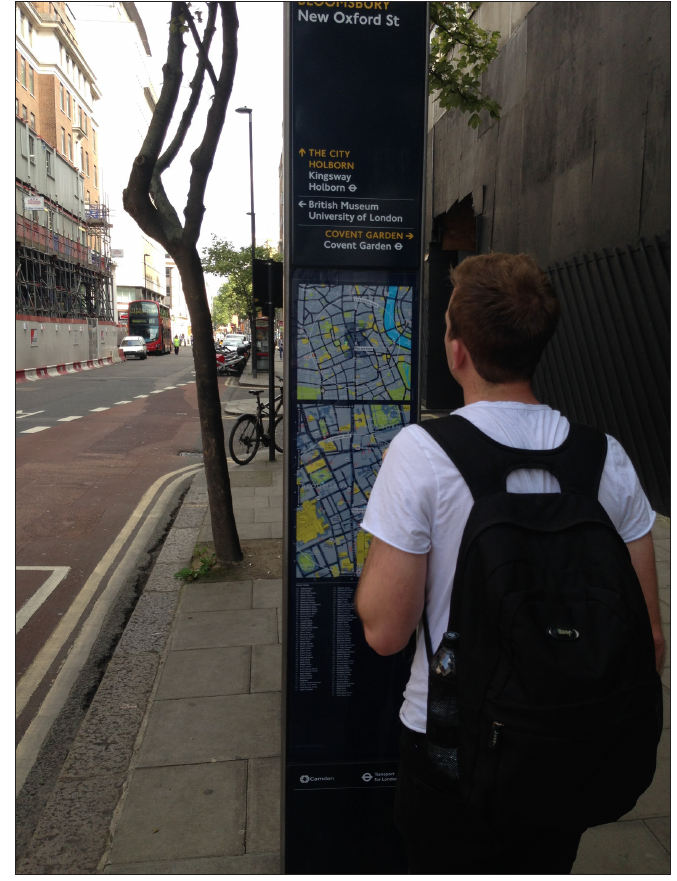
Figure 1: Tom using a street